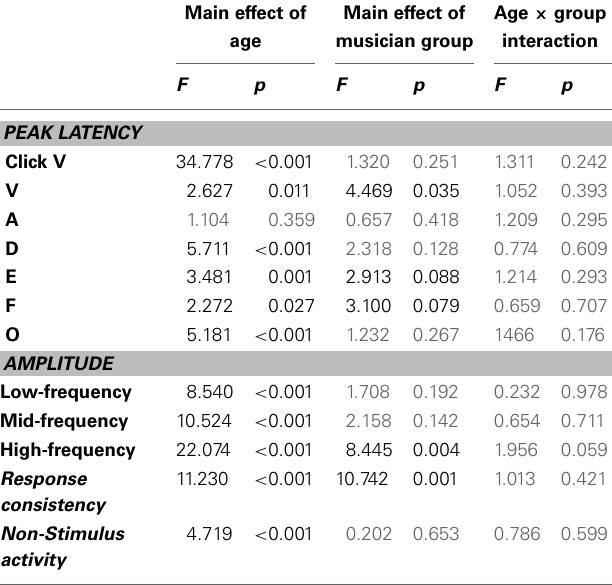
Table 3 | Summary